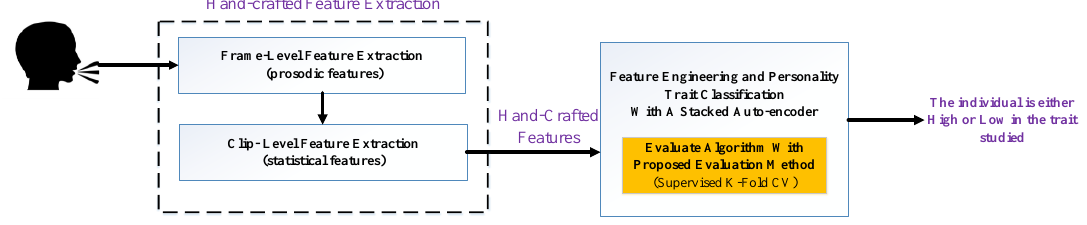
Fig. 1. Network with eight